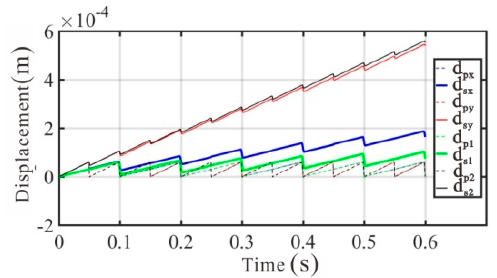
Figure 8. Results of two directions in the 2-DOF PIDM when driven under different frequencies and the two 1-DOF PIDMs driven at the corresponding conditions.